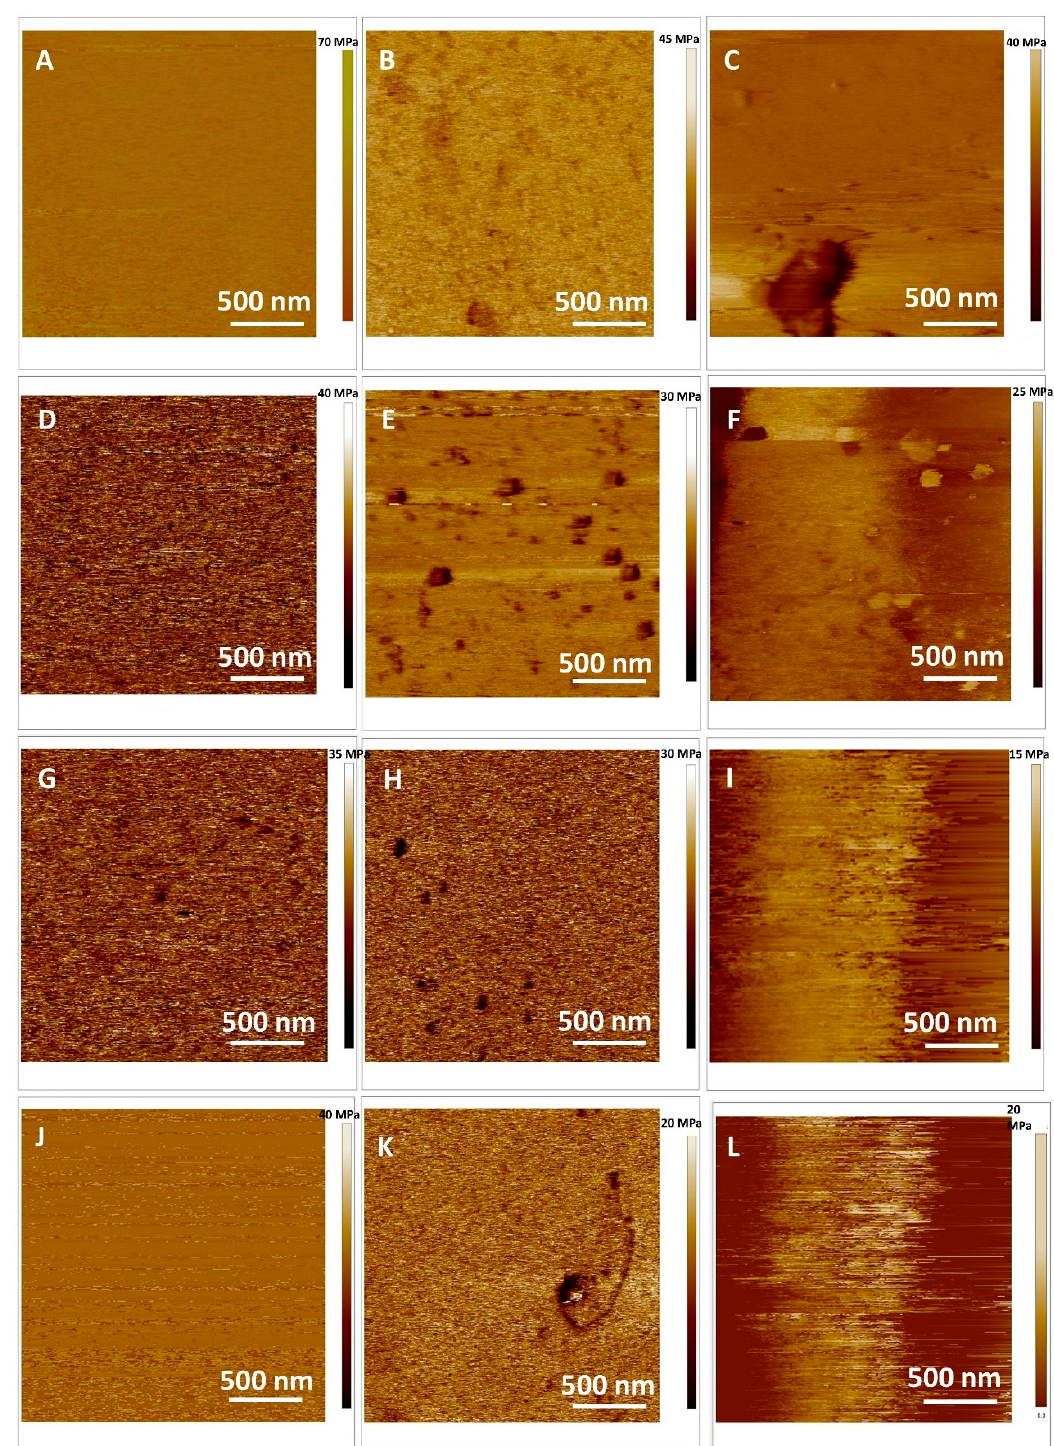
Figure 7. Young modulus maps of the model lipid (DOPC) SLB: ( A – C ) Control; ( D – F ) quercetin loaded DOPC, ( G – I ) myricetin loaded DOPC and ( J – L ) myricitrin loaded DOPC. The lipid peroxidation induced by ( B , E , H , K ) H 2 O 2 , ( C , F , I , L ) H 2 O 2 and Cu 2+ .